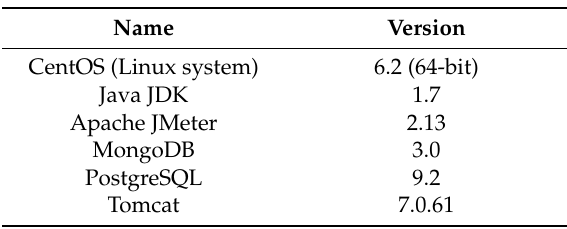
Table 1. Software.